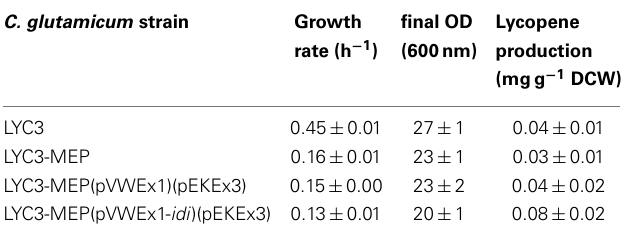
Table 4 | Growth rates and lycopene production by prophage-cured,